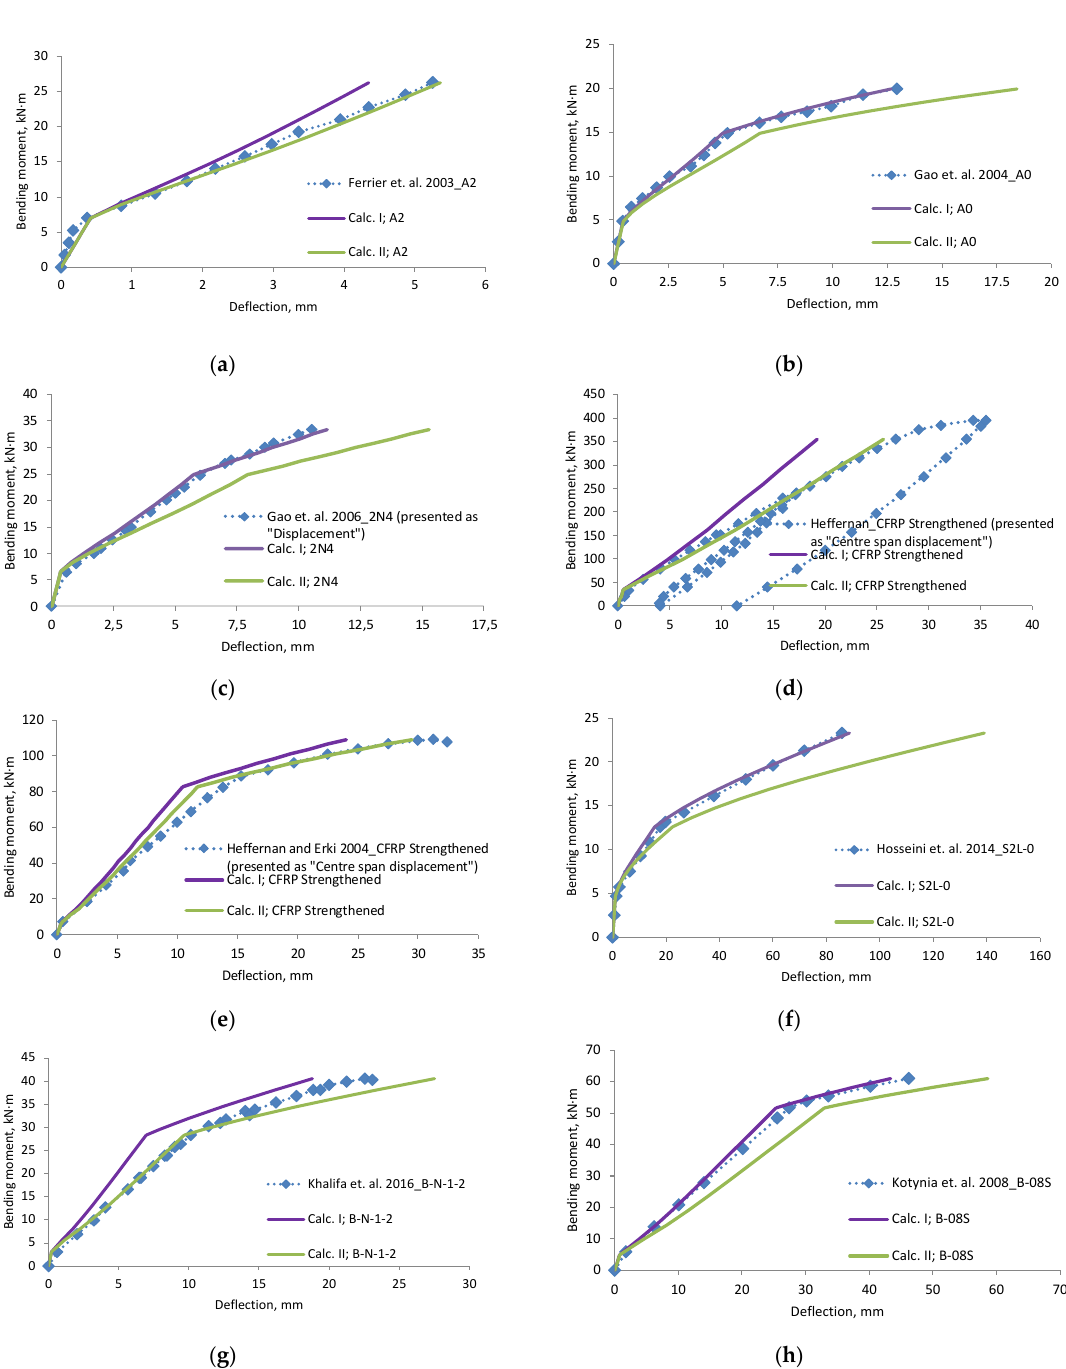
Figure 7. Bending moment–deflection curves, ( a ) beam A2; ( b ) beam A0; ( c ) beam 2N4; ( d ) beam CFRP Strengthened; ( e ) beam CFRP strengthened; ( f ) beam S2L-0; ( g ) beam B-N-1-2; ( h ) beam B-08S.